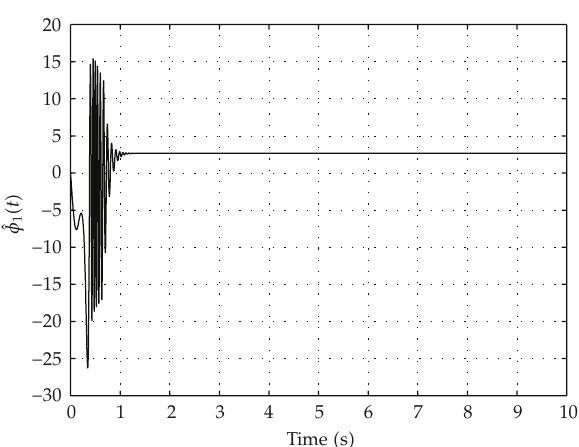
(cid:6) φ 1 (cid:2) t (cid:3) of parameter φ 1